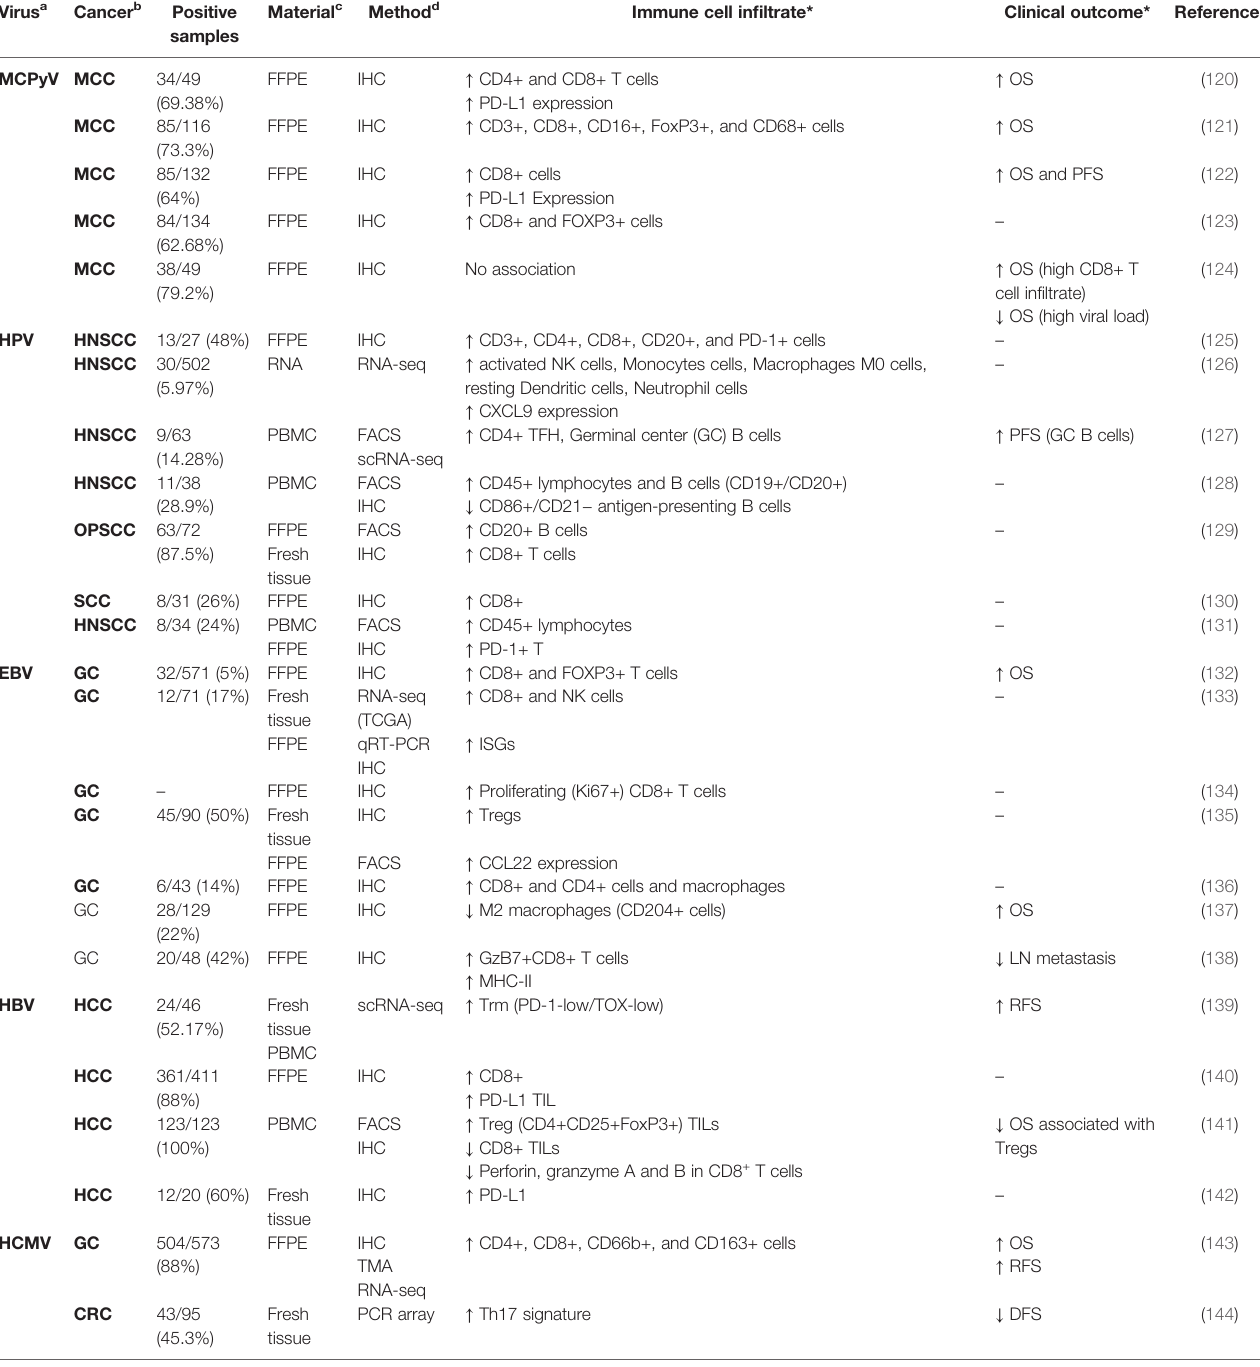
*Unless otherwise speci fi ed, comparisons refer to virus-positive versus virus-negative tumors. a MCPyV, Merkel-cell polyomavirus; HPV, Human papillomavirus; EBV, Epstein-Barr virus; HBV, Hepatitis B virus; HCMV, Human cytomegalovirus. b MCC,Merkelcellcarcinoma;HNSCC,Headandnecksquamouscellcarcinoma;OPSCC,Oropharyngealsquamouscellcarcinoma;SCC,Squamouscellcarcinoma;GC,gastriccancer; HCC, Hepatocellular carcinoma; CRC, Colorectal cancer. c FFPE, Formalin- fi xed paraf fi n-embedded tissue; RNA, Ribonucleic acid; PBMC, Peripheral blood mononuclear cells. d IHC, Immunohistochemistry; RNA-seq, RNA sequencing; FACS, Fluorescent activated cell sorting ( fl ow cytometry); qRT-PCR, quantitative reverse transcriptase polymerase chain reaction; TMA, tissue microarray; PCR, Polymerase chain